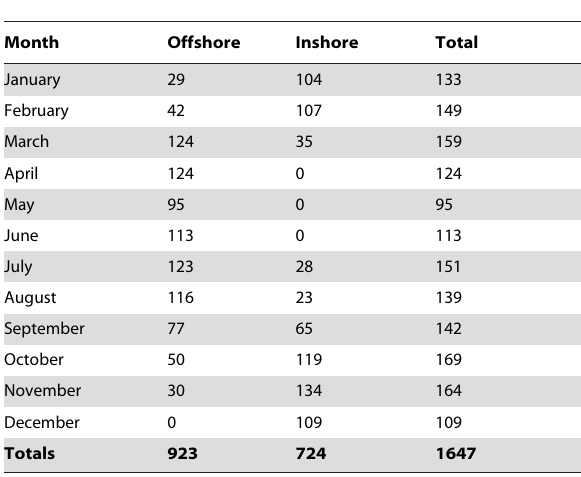
Table 1 . Summary of the total number of shark cage-diving trips per month, inshore and offshore, between January 2007 and December 2011 in Gansbaai, South Africa.